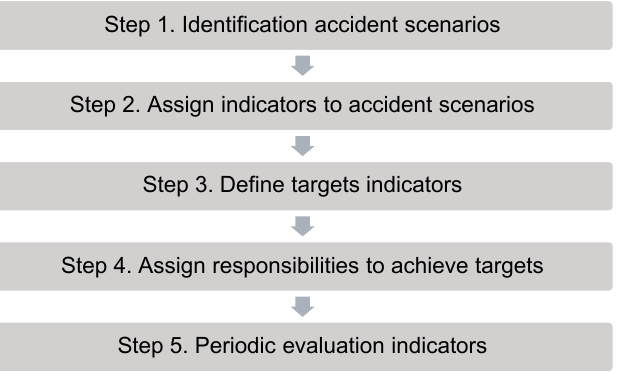
Figure 5. Different steps in the methodology for composing company-specific indicators.